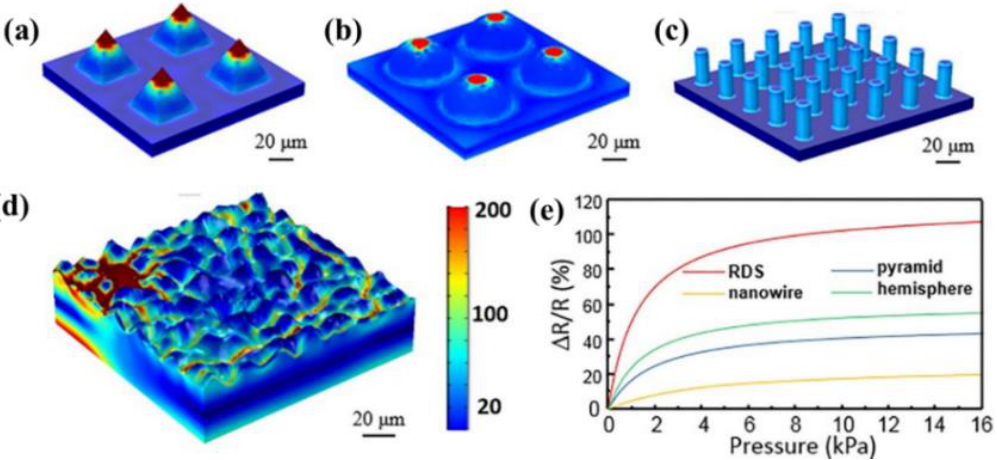
Figure 11. The pressure distribution of ( a ) pyramid, ( b ) hemisphere, ( c ) column, and ( d ) fold microstructures under 5 kPa load, and ( e ) their test results [85]. Table 5. The summary of sensor performances with hierarchical microstructures. Structure Hierarchical sharp bulge